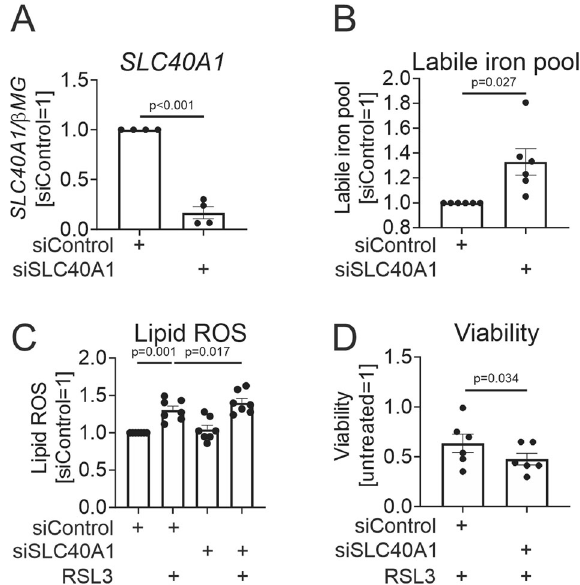
Fig. 2 Ferroportin silencing increases the labile iron pool and exacerbates RSL3-triggered lipid ROS and ferroptosis in human macrophages. A , B mRNA expression of SLC40A1 ( A ), and LIP measurements ( B ) in M Φ transfected with control or SLC40A1 siRNAs for 96 h. C , D Lipid ROS ( C ) and viability ( D ) of M Φ transfected with control or SLC40A1 siRNAs for 96h prior to treatments with 10 µM RSL3 for 6 ( C ) or 24h ( D ). Data are presented as means ± SEM ( N ≥